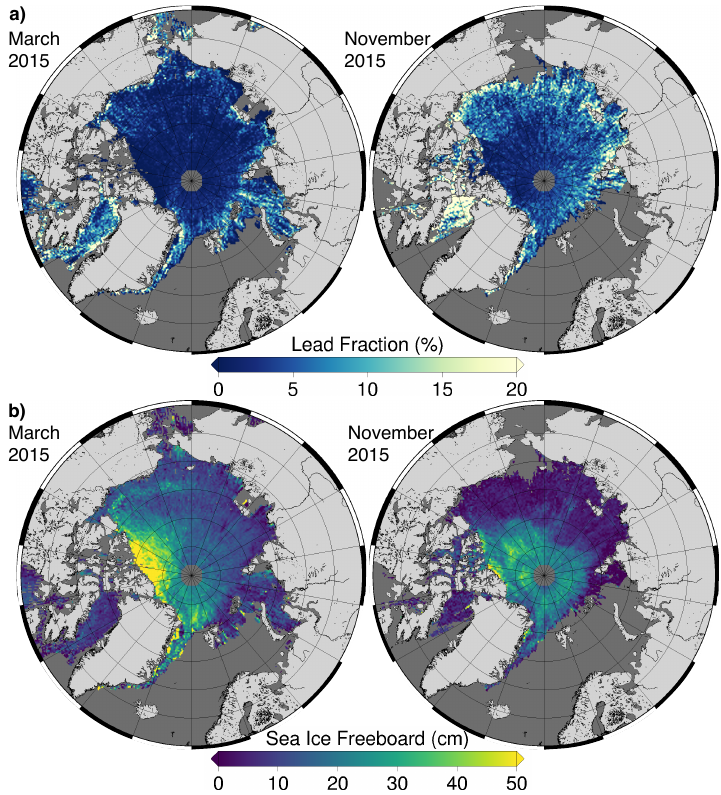
Figure 7. ( a ) The lead fraction is calculated as the percentage of CryoSat-2 waveforms that are classified as leads within a 25 × 25 km grid cell. The new formed ice in autumn generally features more leads than in spring. Also note the low lead fraction in the multiyear ice region north of Greenland and within fast ice areas like the Laptev Sea; ( b ) The sea-ice freeboard is a monthly mean, averaged on a 25 × 25 km EASE2 grid. It clearly shows the contrast between thick multiyear ice north of Greenland and Canada and the thinner first-year ice, respectively new formed